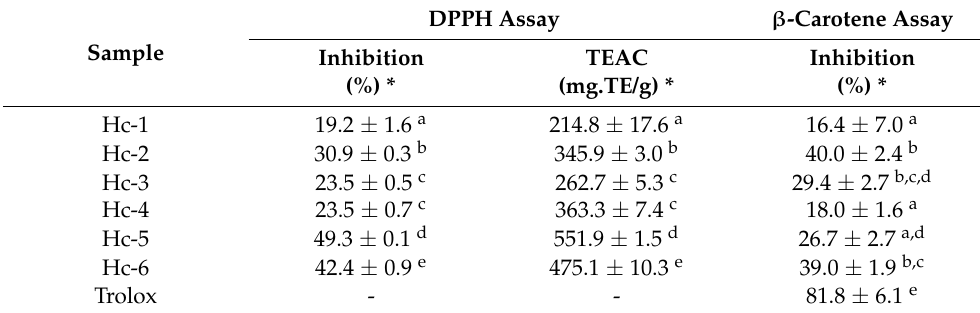
Table A3. Antioxidant capacity of the oils of Hyptis crenata